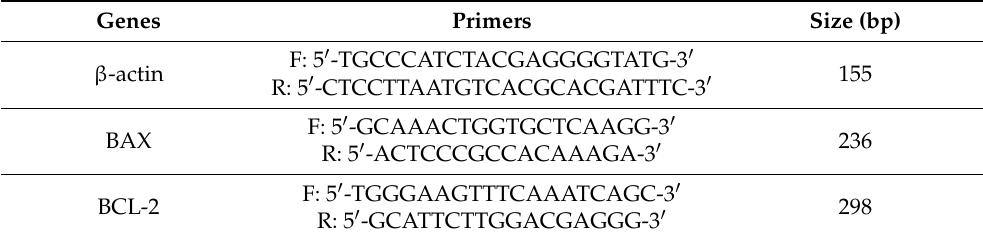
Table 1. Sequences of primers used in real-time